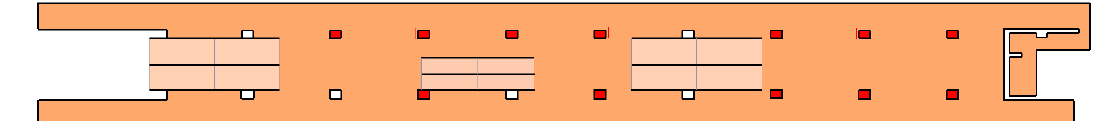
Figure 6. Model plan of platform 5.